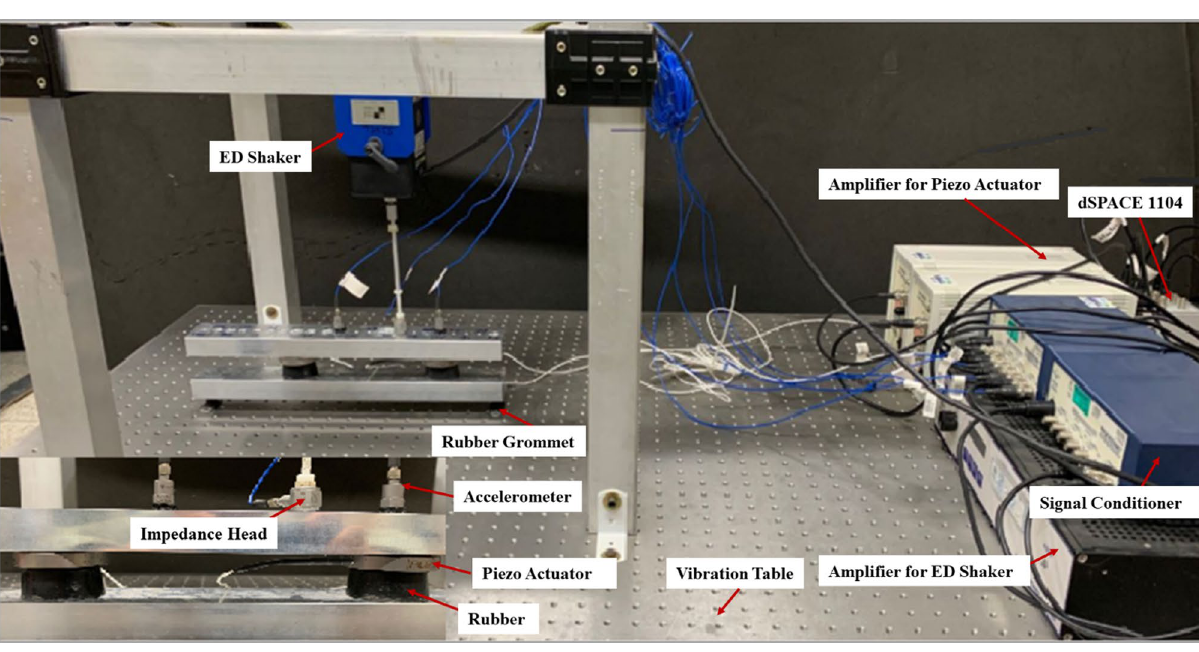
Figure 21. Experimental setup for active vibration control of